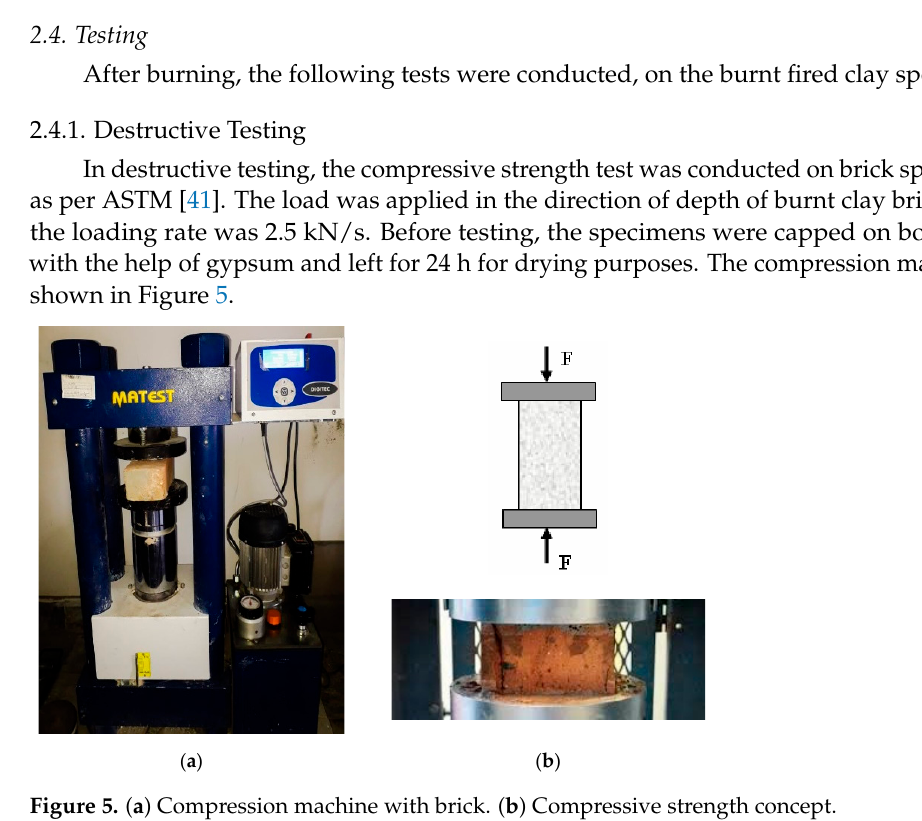
Figure 6. Ultrasonic pulse velocity working flow diagram [43].